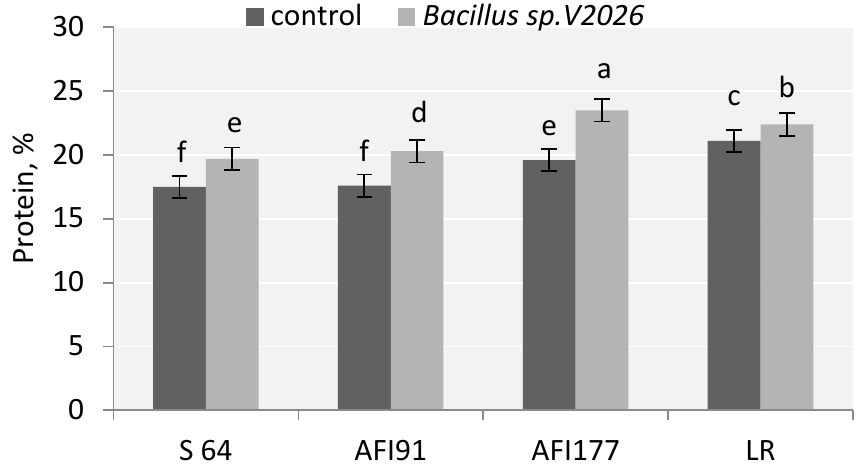
Figure 2. Effect of inoculation with Bacillus sp. V2026 on content of grain protein of early-maturing wheat. Bars with different letters are significantly different at p ≤ 0.05, as determined by Duncan’s multiple range test.